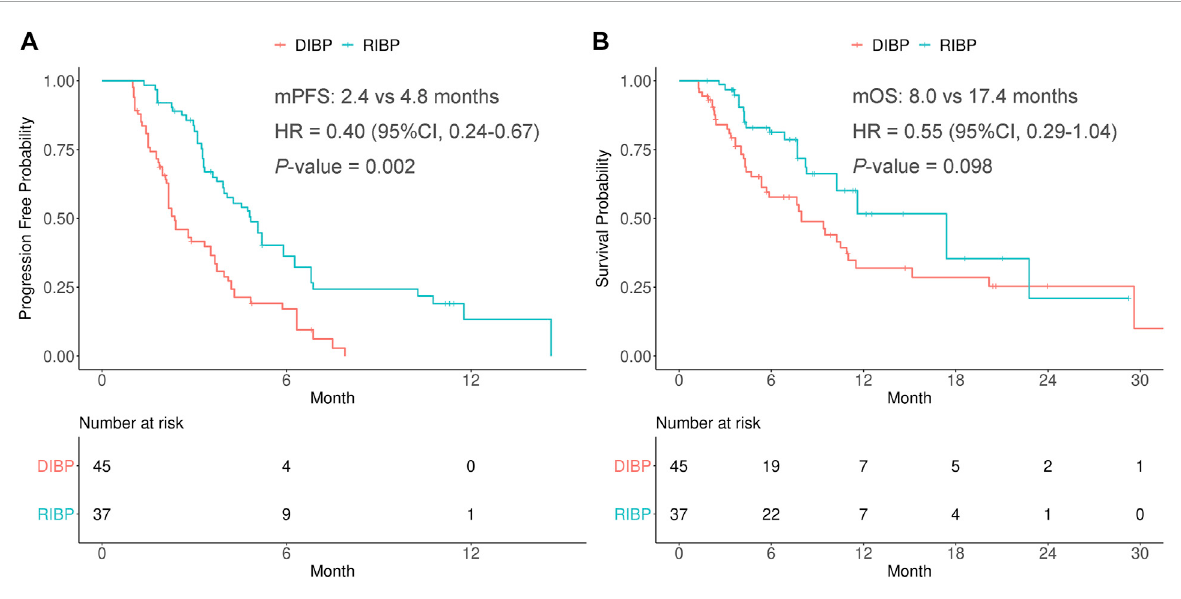
FIGURE 1 Kaplan-Meier curves of PFS (A) and OS (B) from weighted data in the total study population. RIBP, rechallenge of immunotherapy beyond progression; DIBP, discontinuation of immunotherapy beyond progression; mPFS, median progression-free survival; mOS, median overall survival; HR, hazard ratio; CI, con fi dence